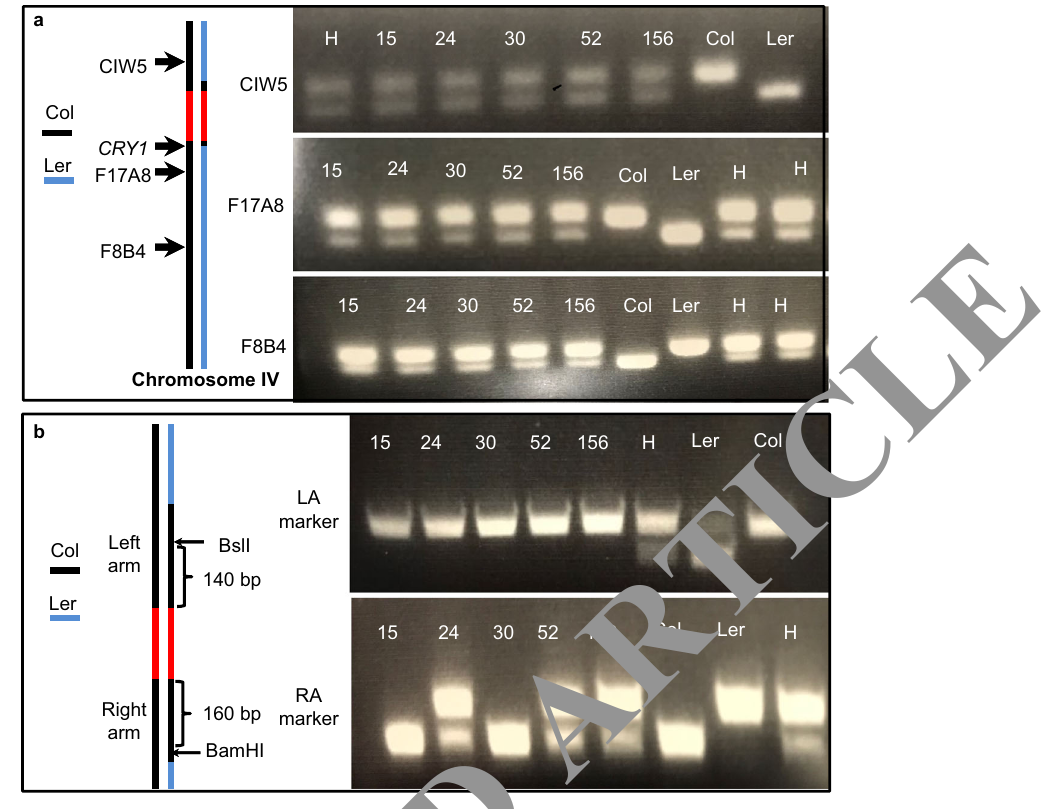
Fig. 2 Determination of the molecular nature and sources of DNA in the homozygous F1 plants. a The homozygous F1 plants are truly generated by HDR in the F1 generation. The homozygous plants contain one copy of Ler DNA and one copy of Col DNA in all regions except for the CRY1 locus, where both copies of DNA were from the Col parent. The CIW5, F17A8, and F8B4 are Simple Sequence Length Polymorphism (SSLP) markers that can differentiate Col DNA from Ler DNA. The genotyping experiments were repeated three times. b Estimation of the break points of HDR by analyzing DNA markers located within the homology arms, which were used to place the gene drive element inside the CRY1 gene through HDR. The Cleaved Ampli fi ed Polymorphic Sequence (CAPS) marker LA uses the BslI enzyme to cut Ler DNA, but Col DNA is not digestible by BslI. The RA marker, which is 160 bp away from the gene drive element, can differentiate Col DNA from Ler when BamHI digestion is used. Genomic DNA was used as the PCR template. The PCR fragments were then digested with the corresponding enzymes. H refers to DNA from F1 plants generated from a cross between wild type Ler and wild type Col. The genotyping experiments were repeated three times. Source data are provided as a Source Data fi (Supplementary Fig. 7). Consistent with the results of the LA and RA markers, the left arm of the 5 F1 plants only had Col DNA and three of the fi ve F1 plants had both Ler/Col DNA in the right arm (Supplementary Fig. 7).